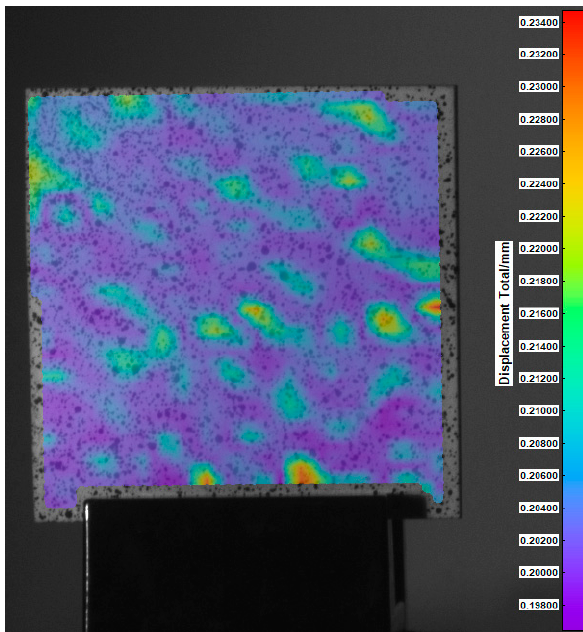
Figure 7. The displacement results: ( a ) X direction and ( b ) Z direction.